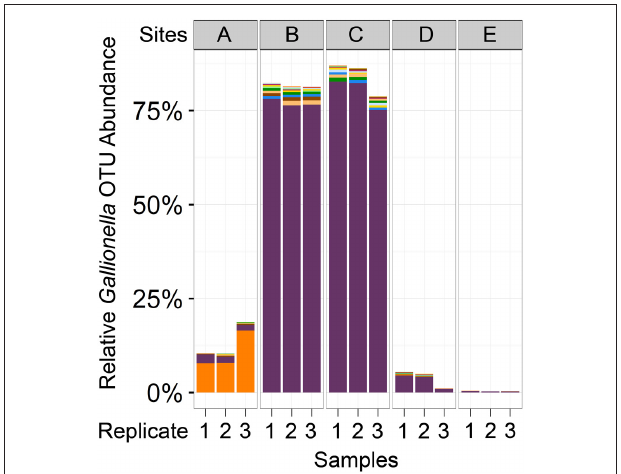
FIGURE 3 | Abundance of Gallionella OTUs across samples. Bar plots represent the number of reads assigned to all OTUs classified as Gallionella . Each color represents a different OTU. The two most abundant Gallionella OTUs (purple and orange) represented 87% of all reads assigned to any Gallionella OTU. Purple, OTU 830064; orange, OTU 4342654 (Greengenes